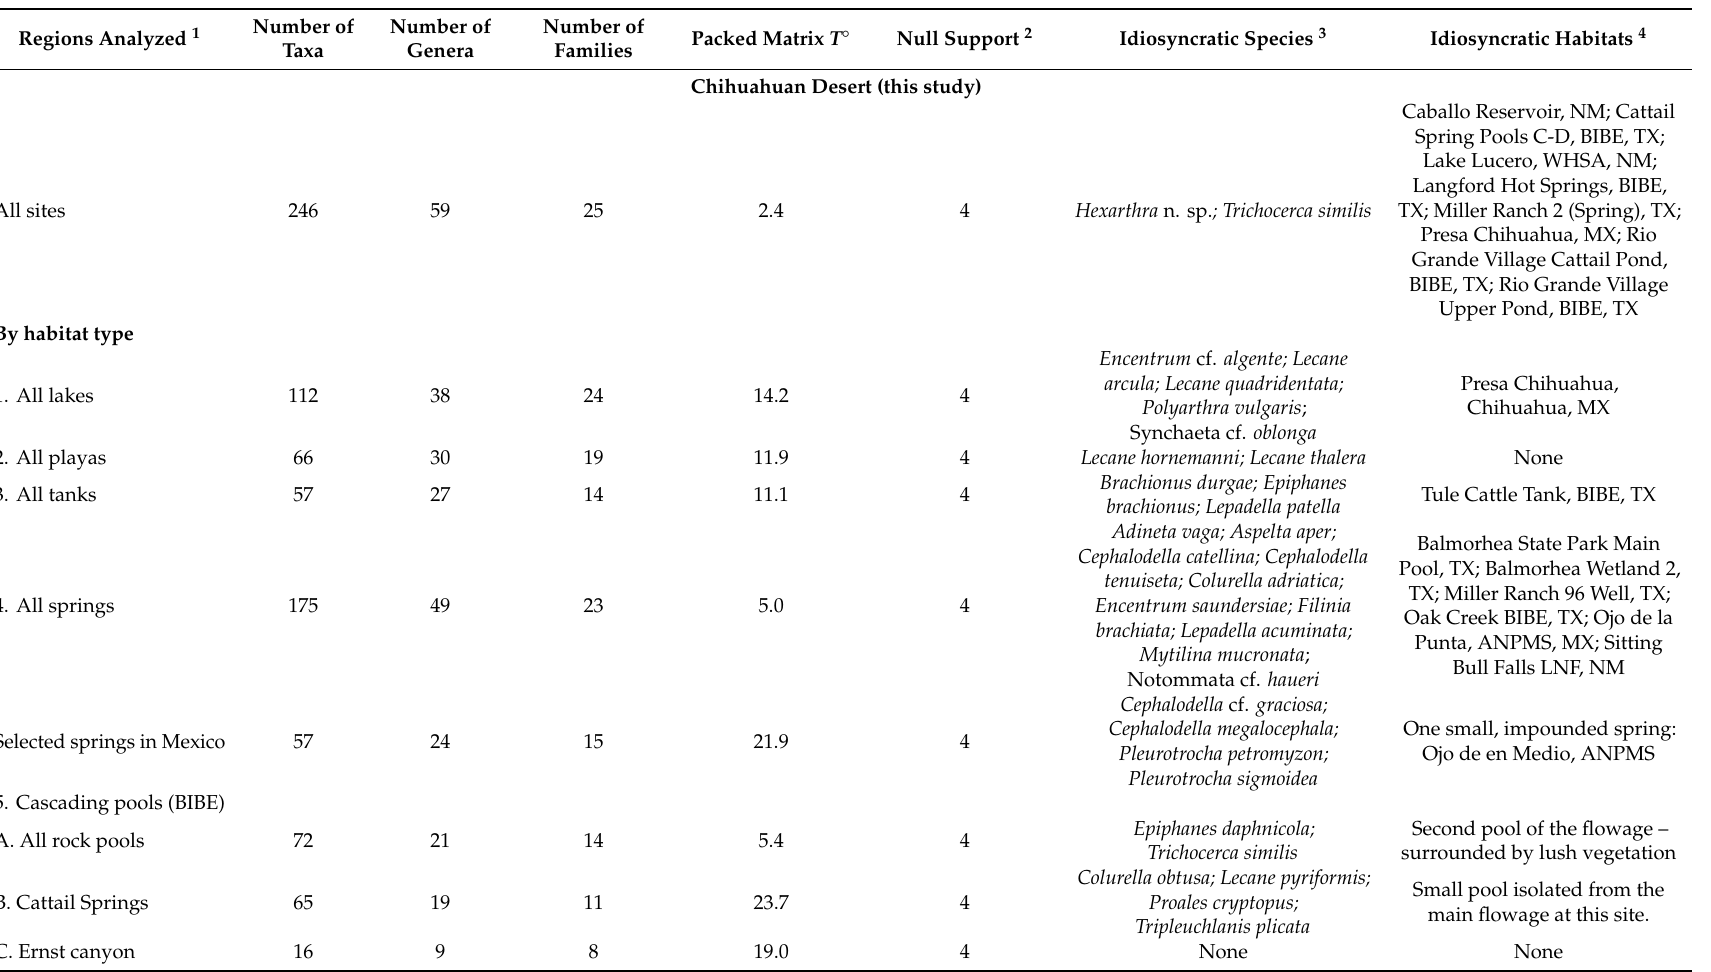
Table 3. Comparative statistics of nestedness among selected studies based on presence / absence data of rotifer species. (See Table A1 for an explanation of the sites, including the abbreviations used